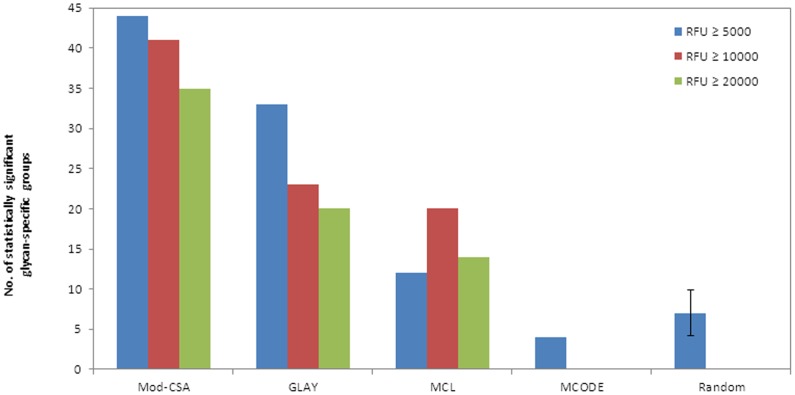
The number of statistically significant glycan-specific groups are shown for three networks generated with RFU cutoff values of 5000 (blue), 10000 (red), 20000 (green).The random clusterings are generated using the four community results of Mod-CSA, and the average and the standard deviation is calculated from 20 runs.